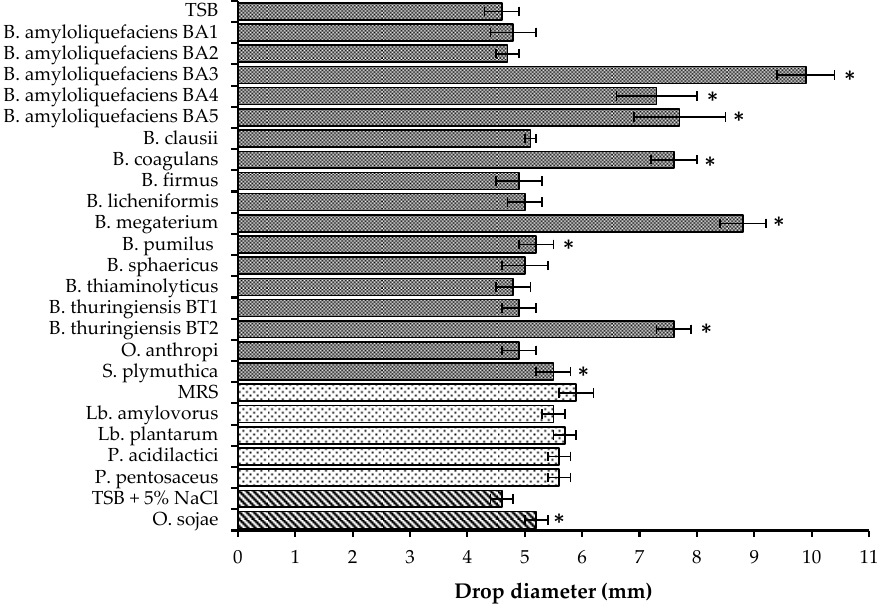
Figure 2. Biosurfactant activity of bioprotective isolates. Error bars indicate standard deviation. Media used are designated by bars with corresponding patterns. Cultures grown in TSB , MRS , and TSB + 5% NaCl . Asterisks indicate drop diameters significantly larger than that of the media control ( α = 0.05).